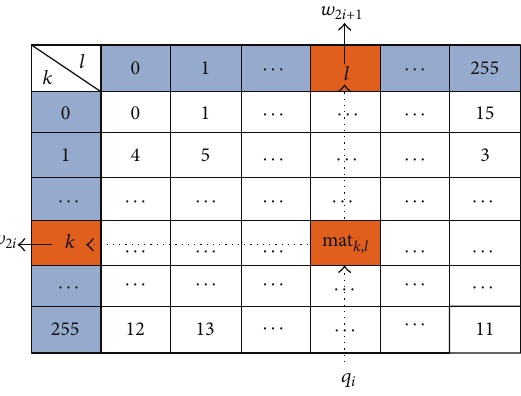
Figure 4: To obtain the cover vector 𝑊